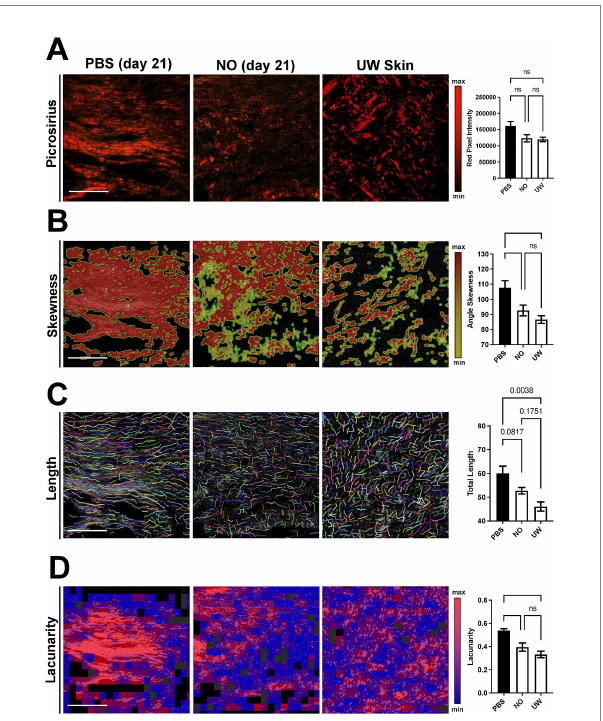
FIGURE 2 Picrosirius red staining and comparison of NO and PBS-gel-treated wounds, using collagen algorithms CurveAlign, CT-Fire, and FracLac. Scale bars: 200 μ m. Quantification of (A) collagen fiber pixel intensity, (B) fiber angle skewness, (C) fiber length, and (D) tissue lacunarity. ns = nonsignificant. Data are presented as mean value ± SEM, * p <